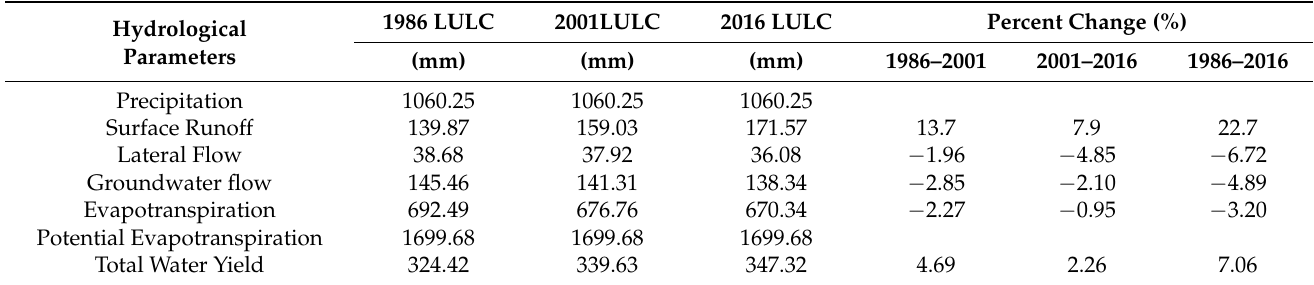
Table 11. Average annual water balances components for 1986, 2001, and 2016